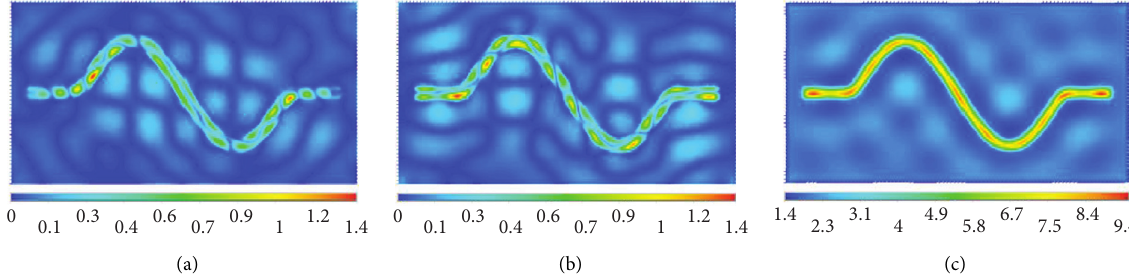
Figure 39: P wave incident ( C